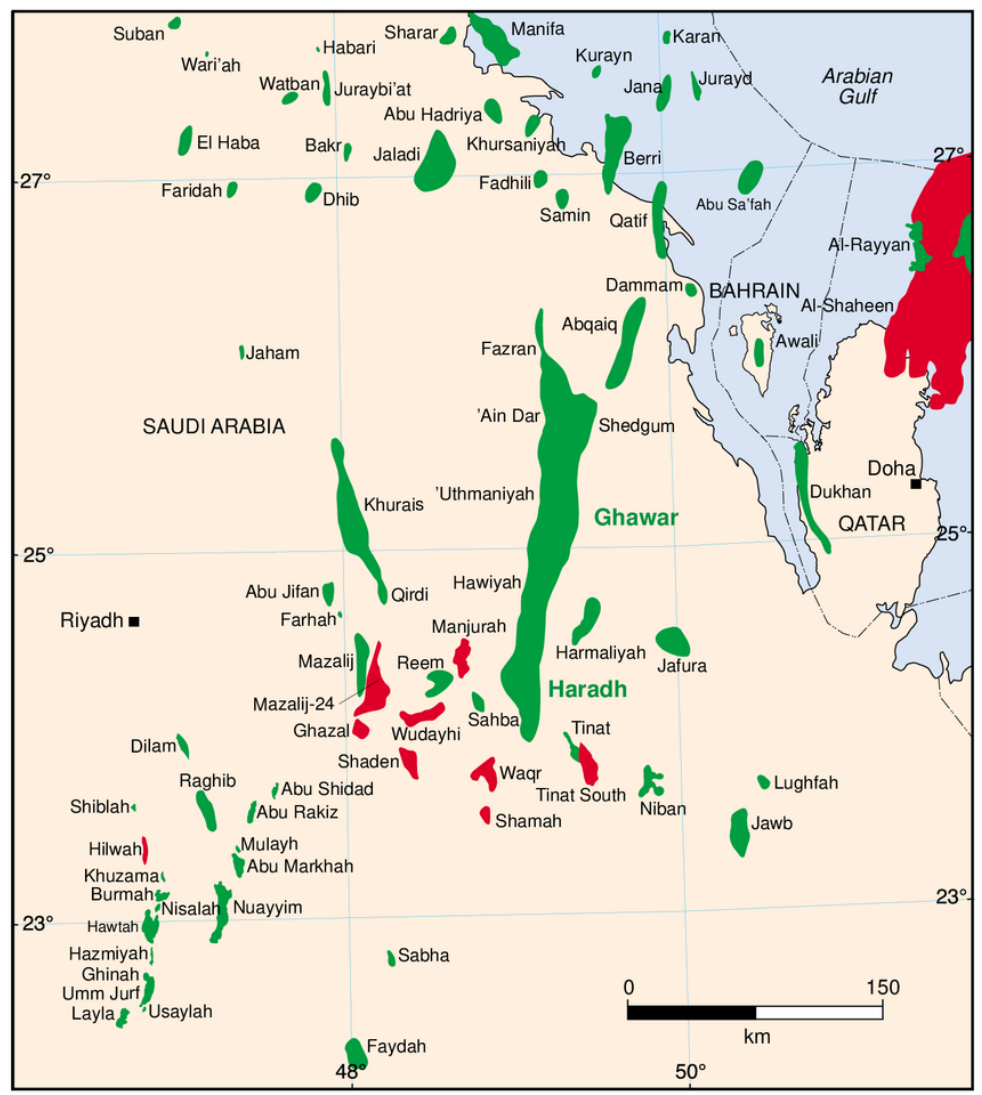
Figure 2. Geographical location of the Ghawar oil field. In the image, the Jurassic oilfields are depicted in green and the gas fields in red (reprinted/adapted with permission from